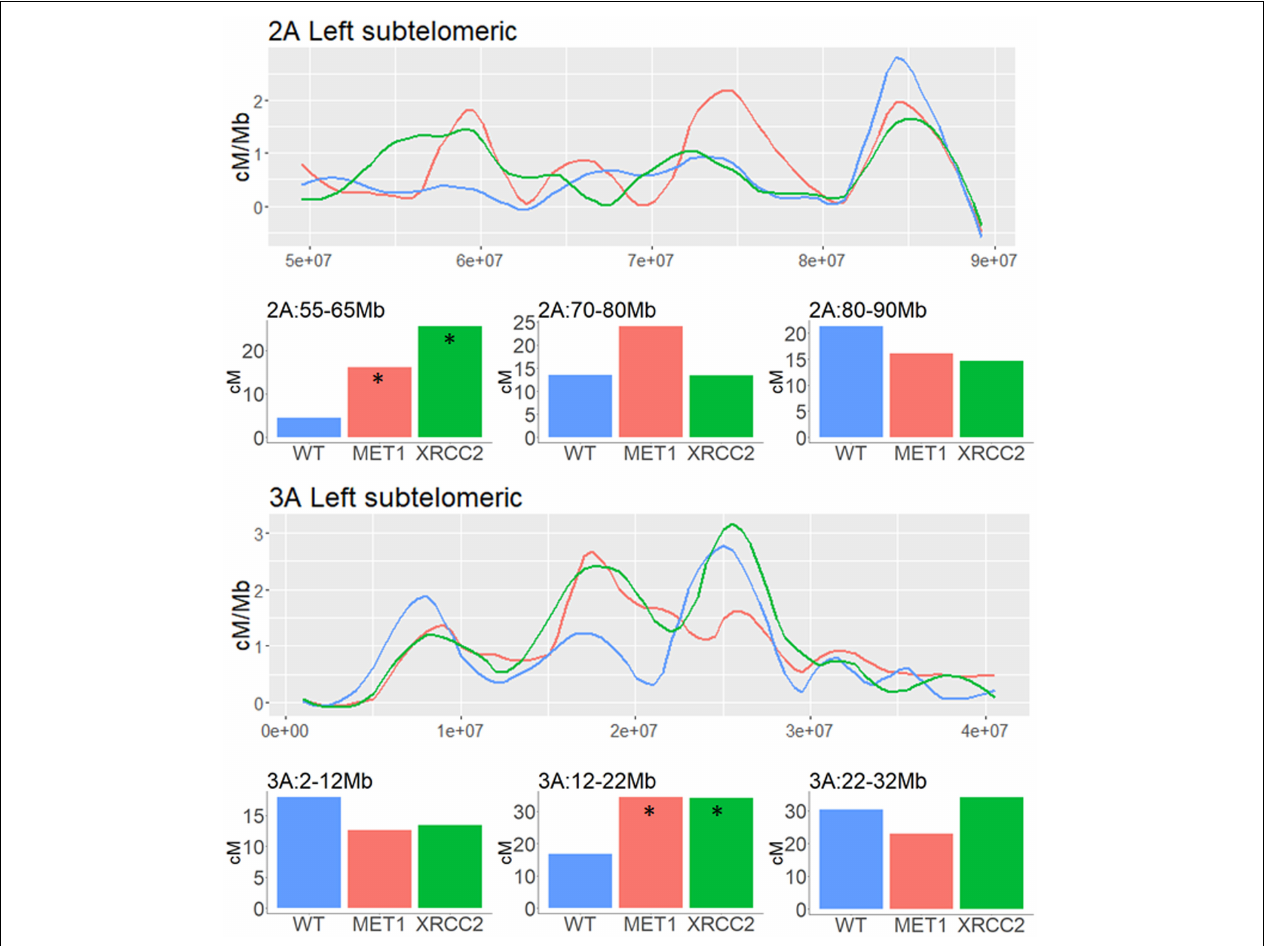
FIGURE 6 | Analysis of genetic distance in subtelomeric regions of three different chromosomes of F2 (Zavitan x Svevo) populations derived from F1 plants which were treated by either MET1-VIGS or XRCC2-VIGS during meiosis or untreated (WT). Lines show the Genetic distance in centi-Morgans per Mb along subtelomeric regions ( X -axis represent bp in Zavitan chromosomes). Bars show the genetic distances in centi-Morgans in three 10 Mb intervals from each subtelomeric region. Asterisk indicate a significant difference from WT (chi-squared test, p < 0.05). Blue, WT control ( N = 89); Red, MET1-VIGS treatment ( N = 87); Green, XRCC2-VIGS treatment ( N =